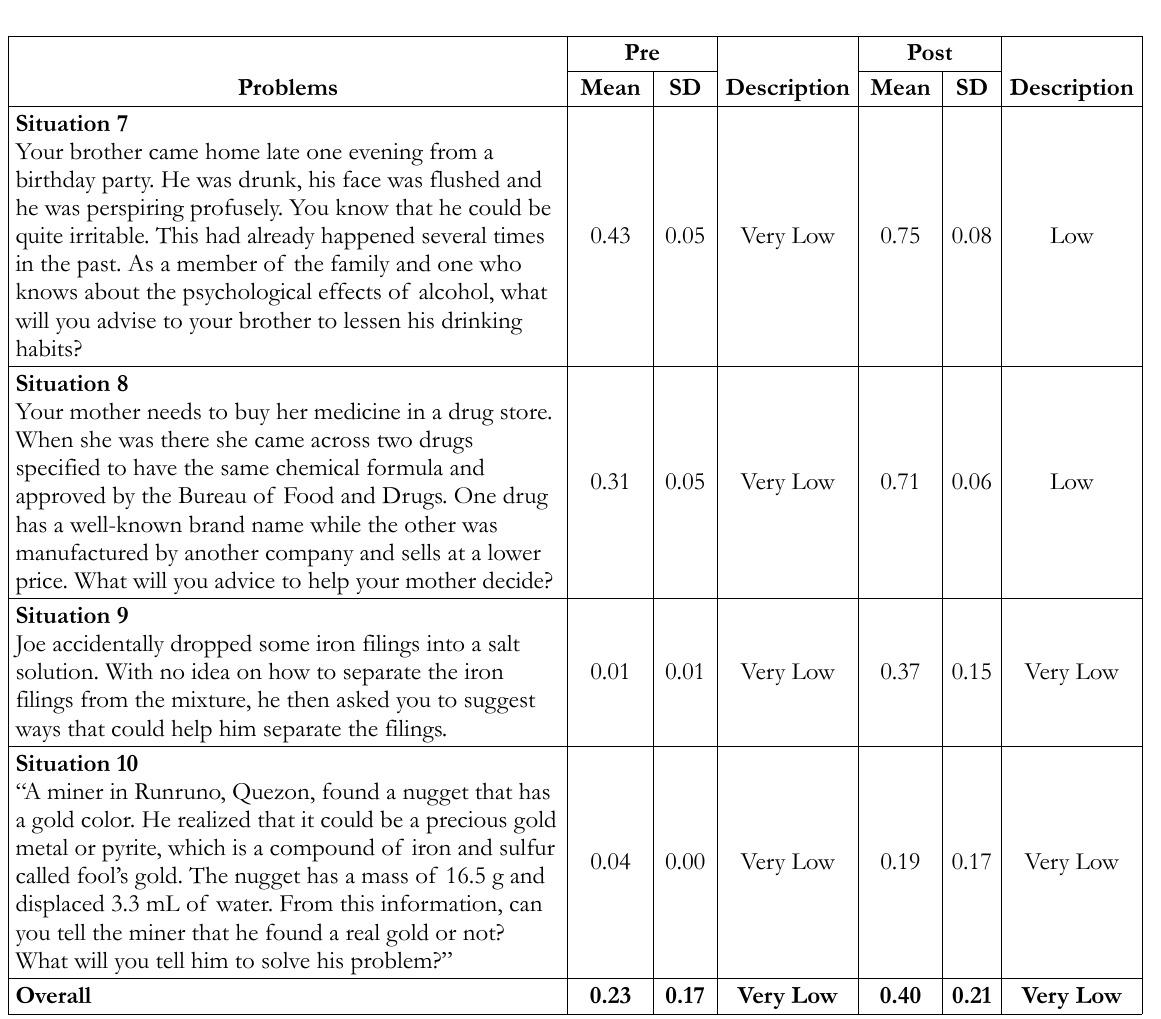
Table 3. The Level of Problem Solving skills of the Non-PBL Group in the Items of the Problem Solving Skill Test Among the 10 problems presented during the pre-test, answers of the students in Situation 1 exhibited the highest mean of 0.52 (low). Moreover, answers of students in Situation 9 surfaced the lowest mean of